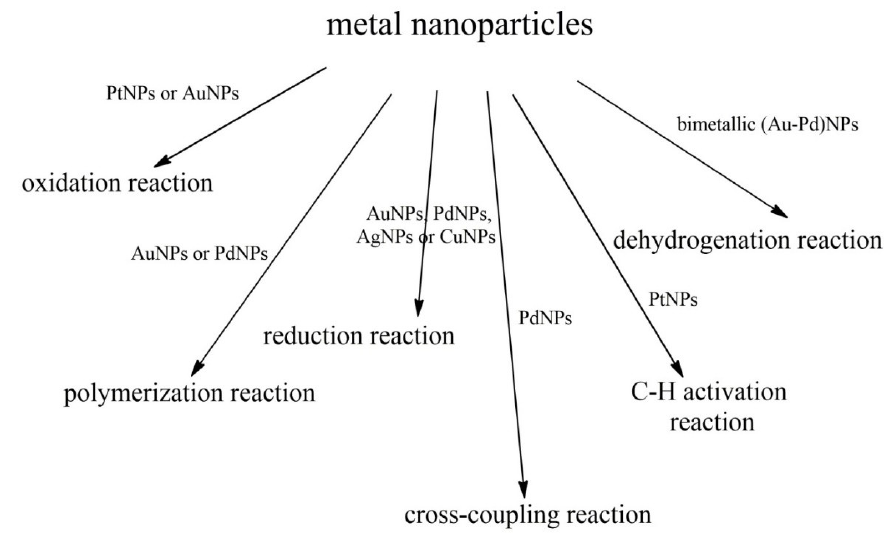
Figure 17. The application of exemplary metal nanoparticles in various catalytic reactions.